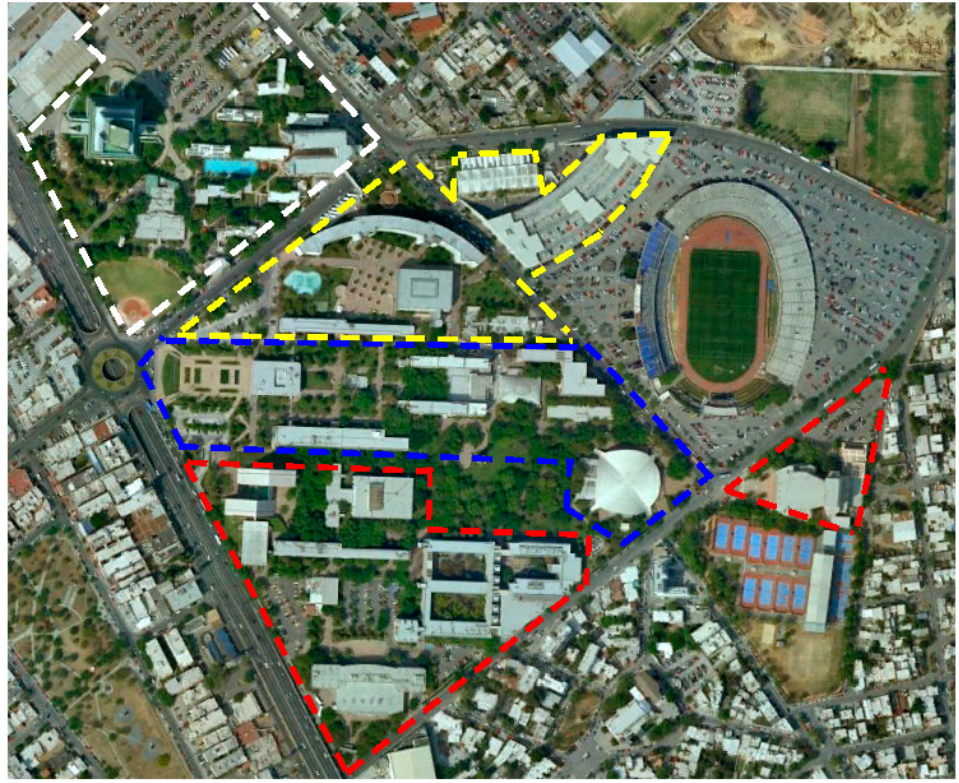
Figure 1. Monterrey Campus and clusters of catchment surfaces. In red, Group 1; in blue, Group 2; in yellow, Group 3; in blank, Group 4; Group 5 is not shown in the figure.